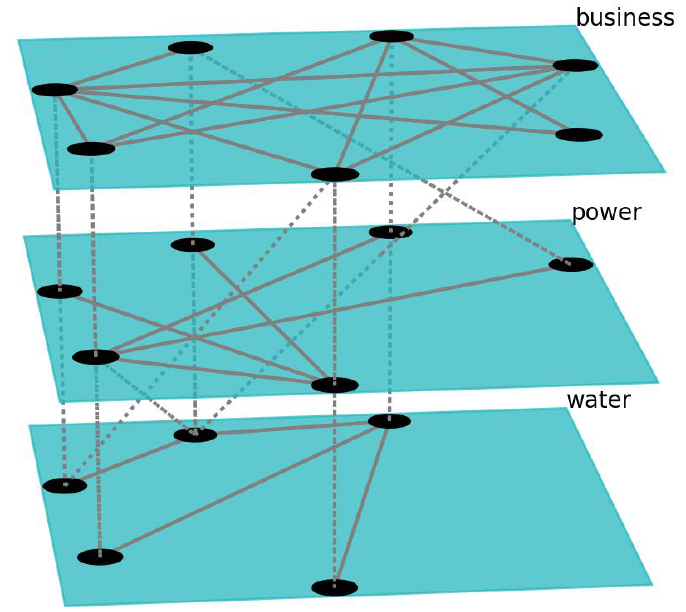
Figure 4. Section of topologies of three simulation experiment